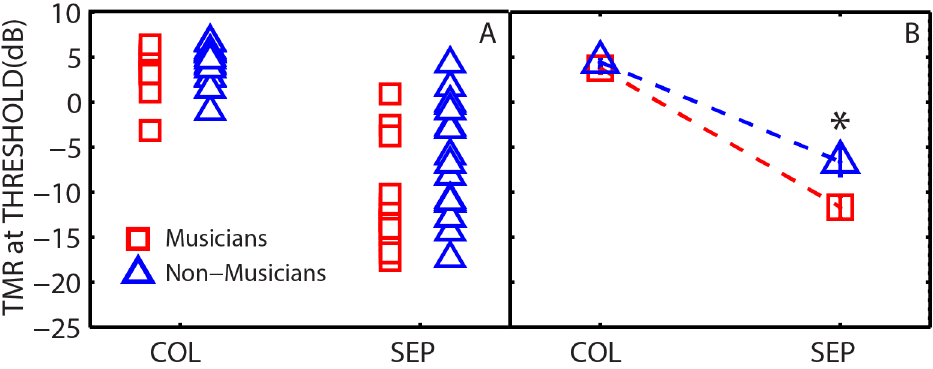
Fig 2. Panel A: Individual target-to-masker ratio at threshold (TMR) for musicians (red squares) and non- musicians (blue triangles) measured in colocated and separated configurations. Panel B: Group mean TMRs for conditions shown in panel A. Error bars are ± 1 standard error of the mean. * Statistically significant group difference at 0.05 level (2 tailed). musicians and non-musicians. The TMRs are plotted for colocated and separated masker con- figurations. Lower TMRs correspond to better thresholds (less masking).